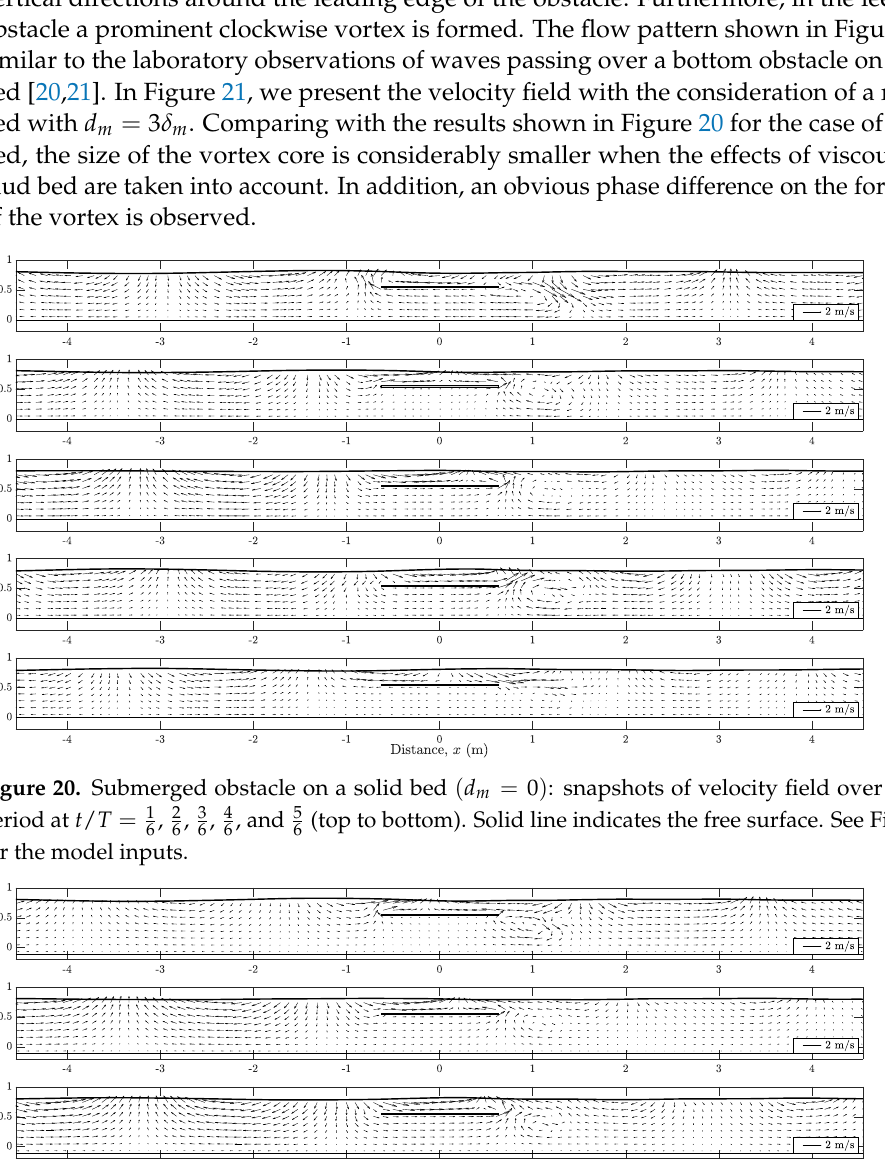
, 2 , 3 , 4 , and 5 . Solid line indicates the free surface. See Figure 18 for the 6 6 6 6 6